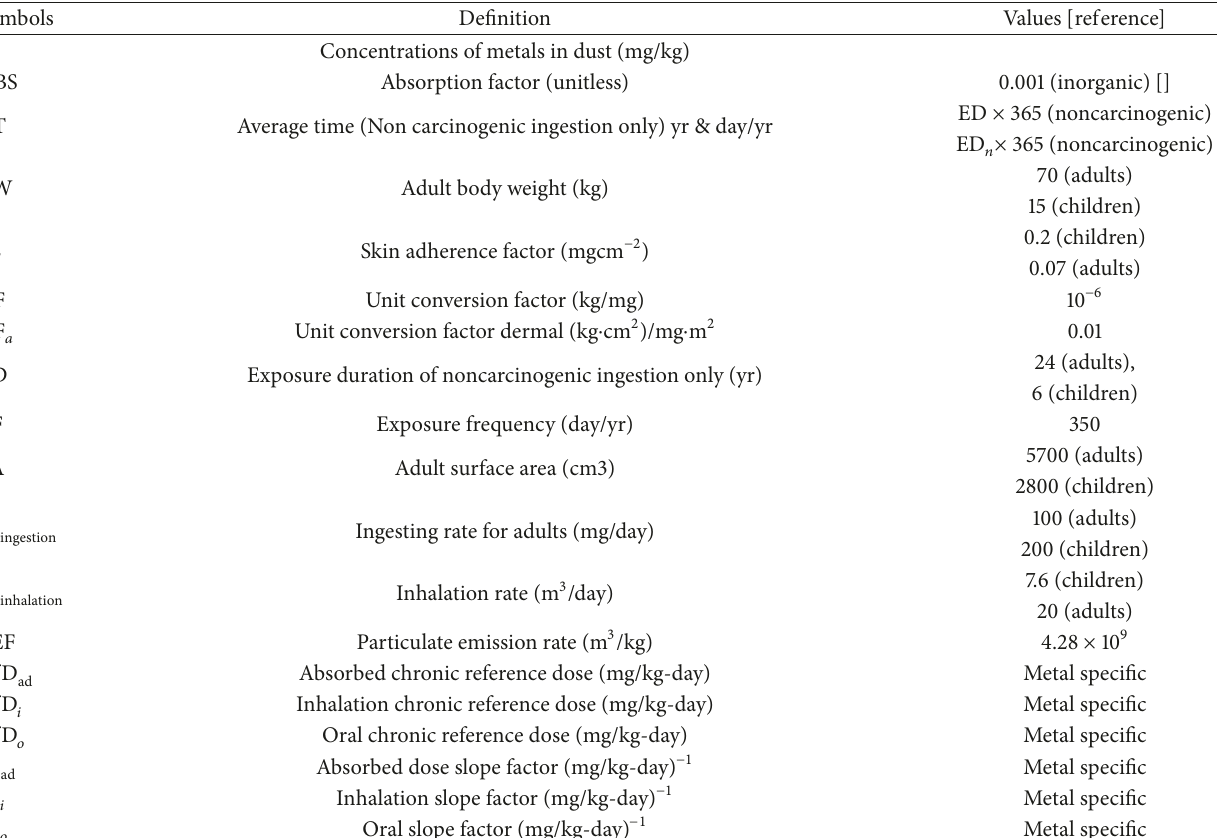
Table 2: Definitions and values of variables used in the estimation of human exposure.